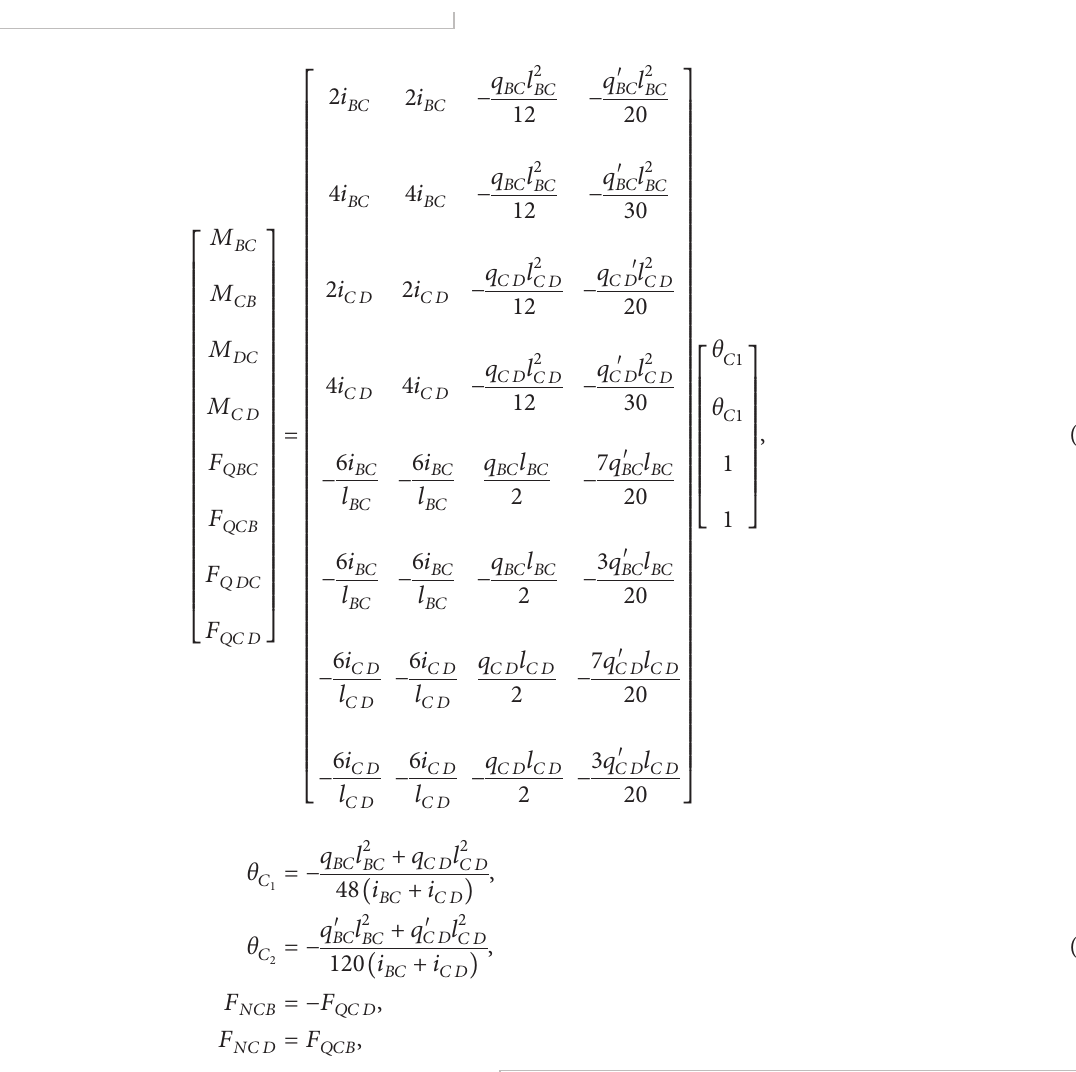
Figure 9, and the analytical calculation of the structural stress of JKLNO is shown in formulas (5) ∼ (8).